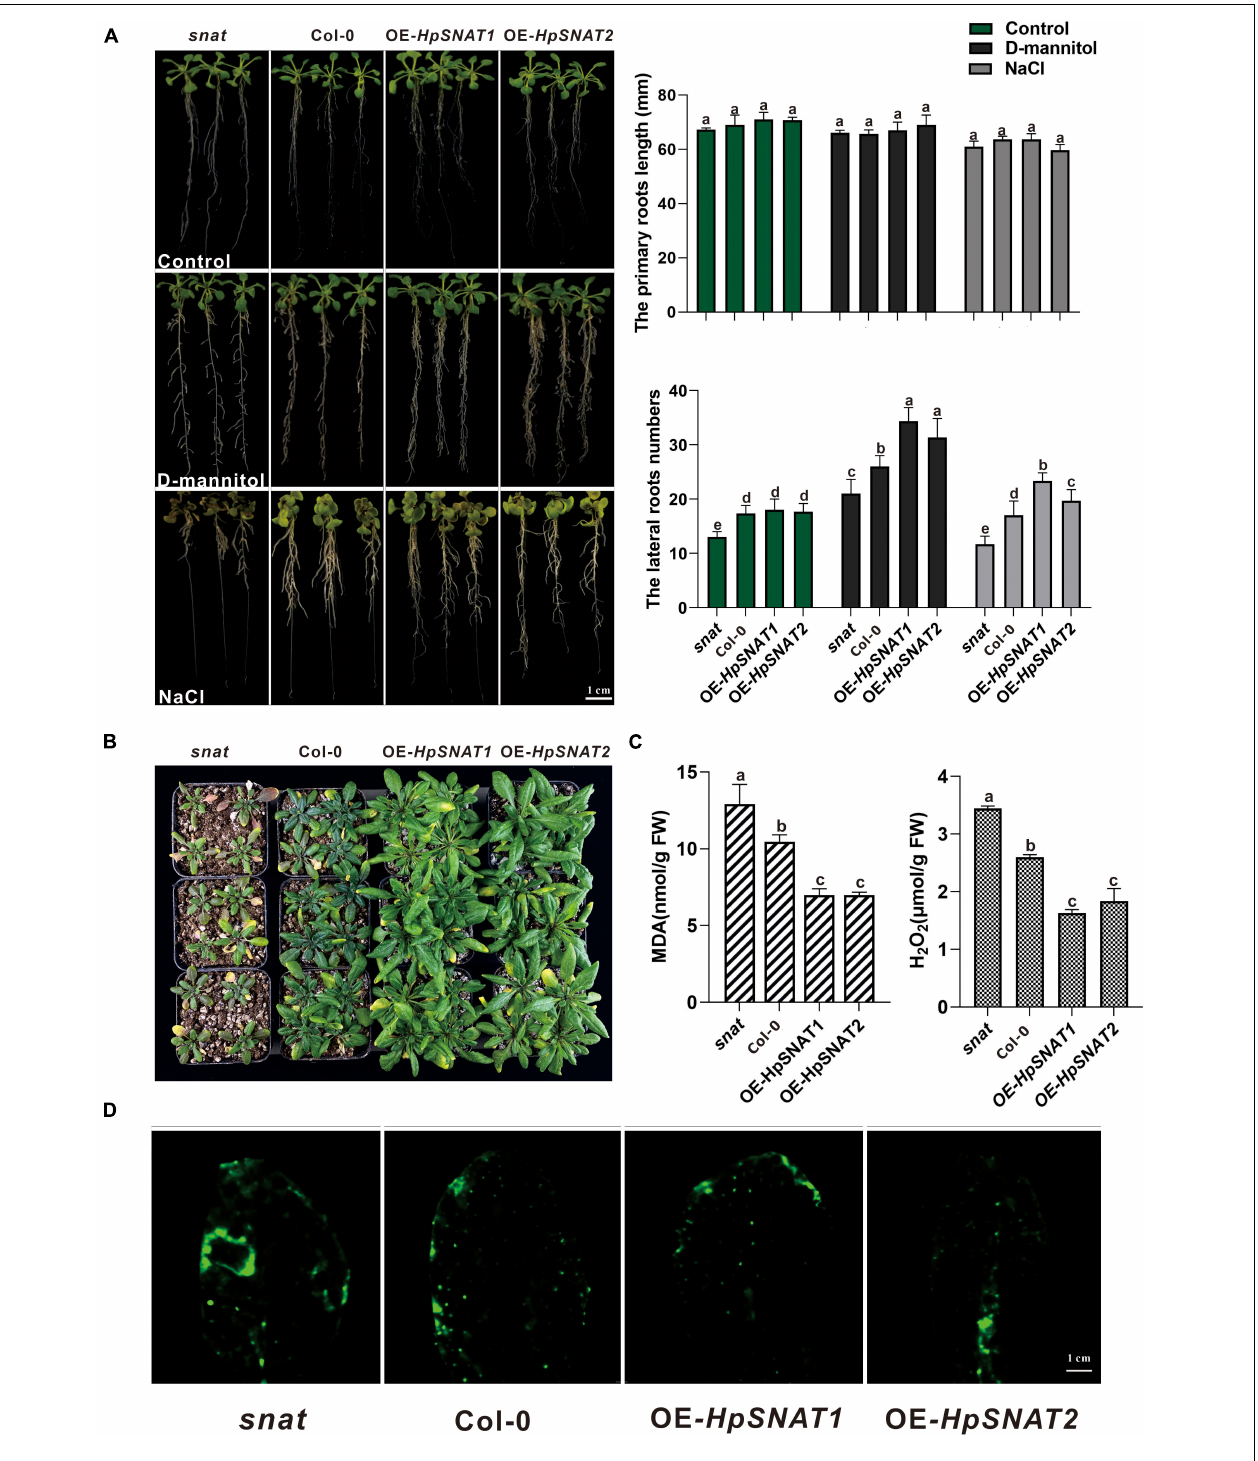
FIGURE 4 | Function of HpSNAT1 and HpSNAT2 when expressed in Arabidopsis plants. (A) The phenotype, primary root length, and lateral root number of snat , Col-0, and OE seedlings under normal condition (control), D-mannitol, and NaCl treatments. Each value represents the average of three replicates, and the error bars represent ± SD. Different letters indicate significant differences from the control ( P < 0.05) tested by one-way ANOVA. (B) Drought tolerance test. Four-week-old plants of snat , Col-0, and OE in soil were dehydrated for 12 days. (C) MDA and H 2 O 2 accumulation in snat , Col-0, and OE lines under drought stress. Each value represents the average of three replicates, and the error bars represent ± SD. Different letters indicate significant differences from the control ( P < 0.05) tested by one-way ANOVA. (D) Histochemical staining with fluorescent CM-H2DCFDA to detect reactive oxygen species in snat , Col-0, and OE lines under drought stress.